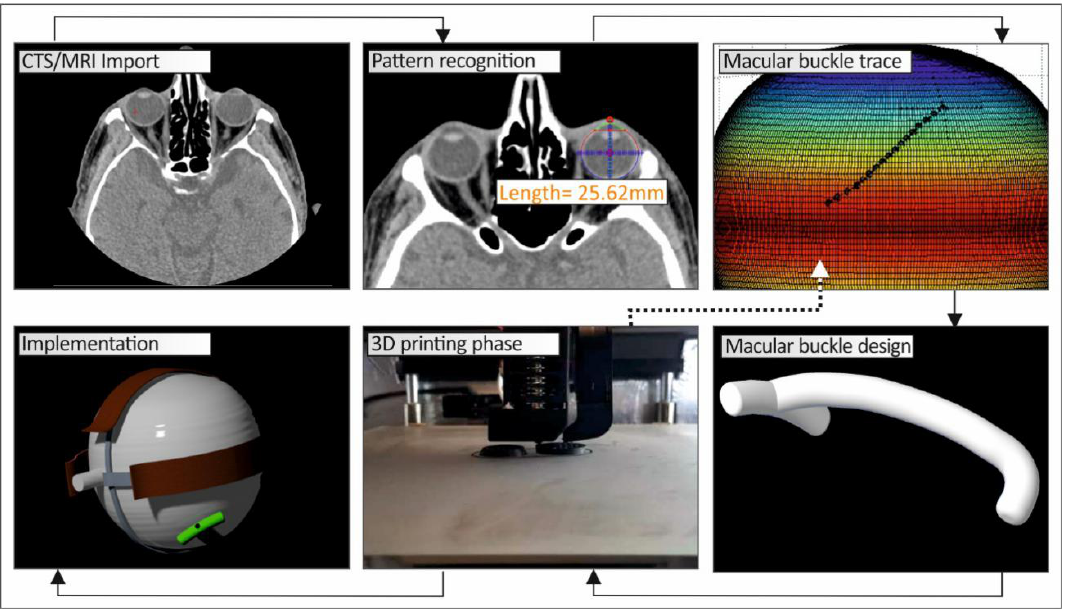
Figure 1. Flow chart describing the methodology developed to produce a personalized macular buckle.